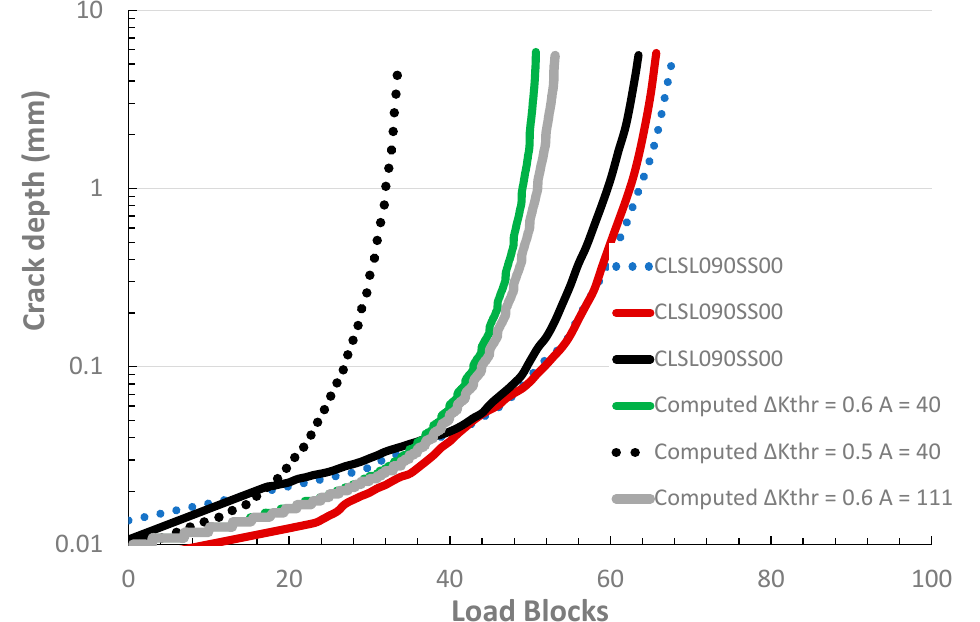
Figure 8. The measured and computed crack depth histories for the helicopter flight load spectrum IRF-E16.